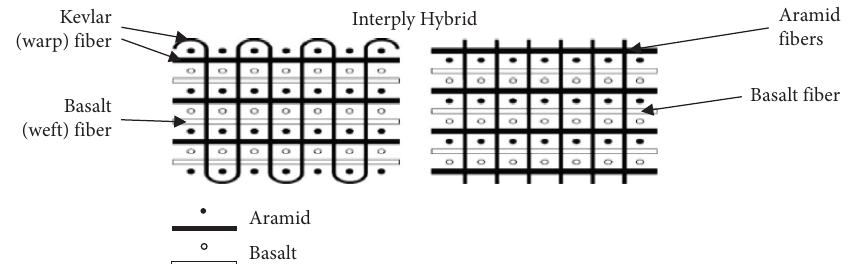
Figure 1: Plain interwoven basalt/aramid hybrid composite